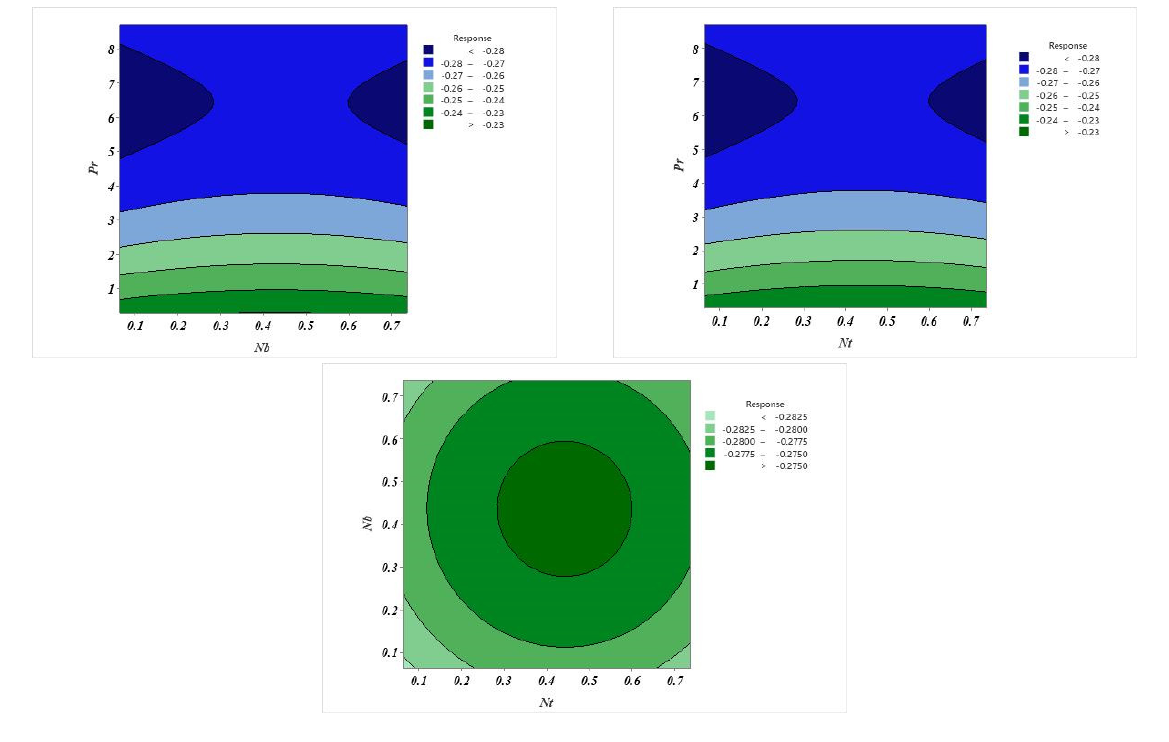
Figure 26. Contour plot.